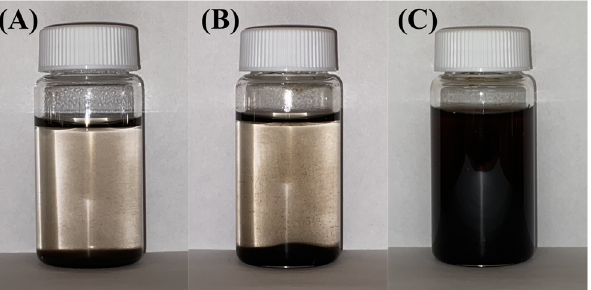
Figure 2. Fe 3 O 4 suspension in water with ( A ) no dispersing agent, ( B ) BA as a dispersing agent, and ( C ) DHBA as a dispersing agent 1 h after